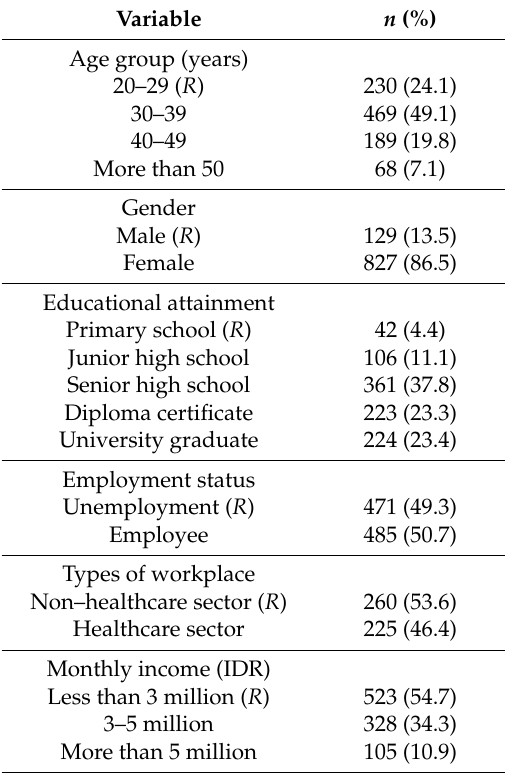
Table 1. Participants’ characteristics ( n =